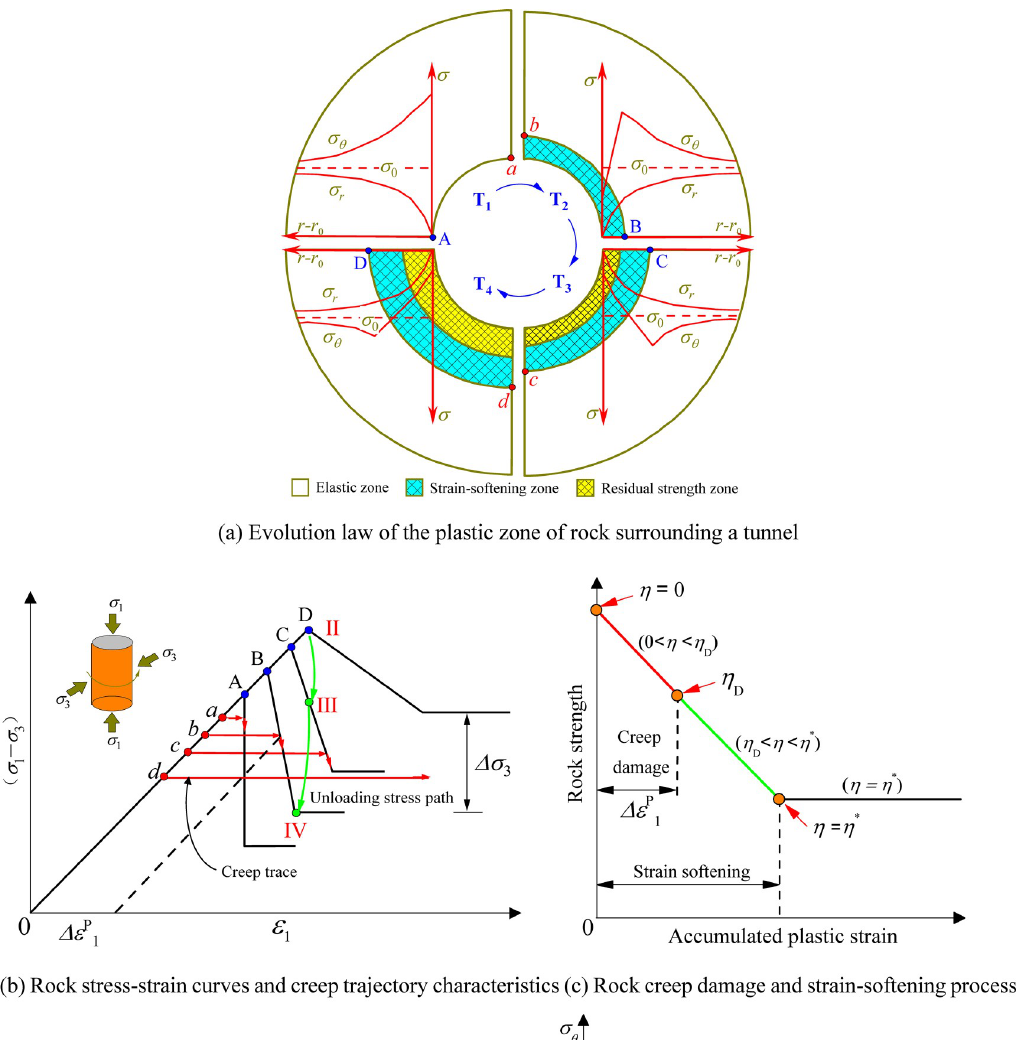
Fig 1. Coupled relationship between creep and strain-softening of rock surrounding a tunnel. (a) Evolution law of the plastic zone of rock surrounding a tunnel (b) Rock stress-strain curves and creep trajectory characteristics (c) Rock creep damage and strain-softening process (d) Rock creep curves at different tunnel positions (e) Unloading path of rock surrounding a tunnel.